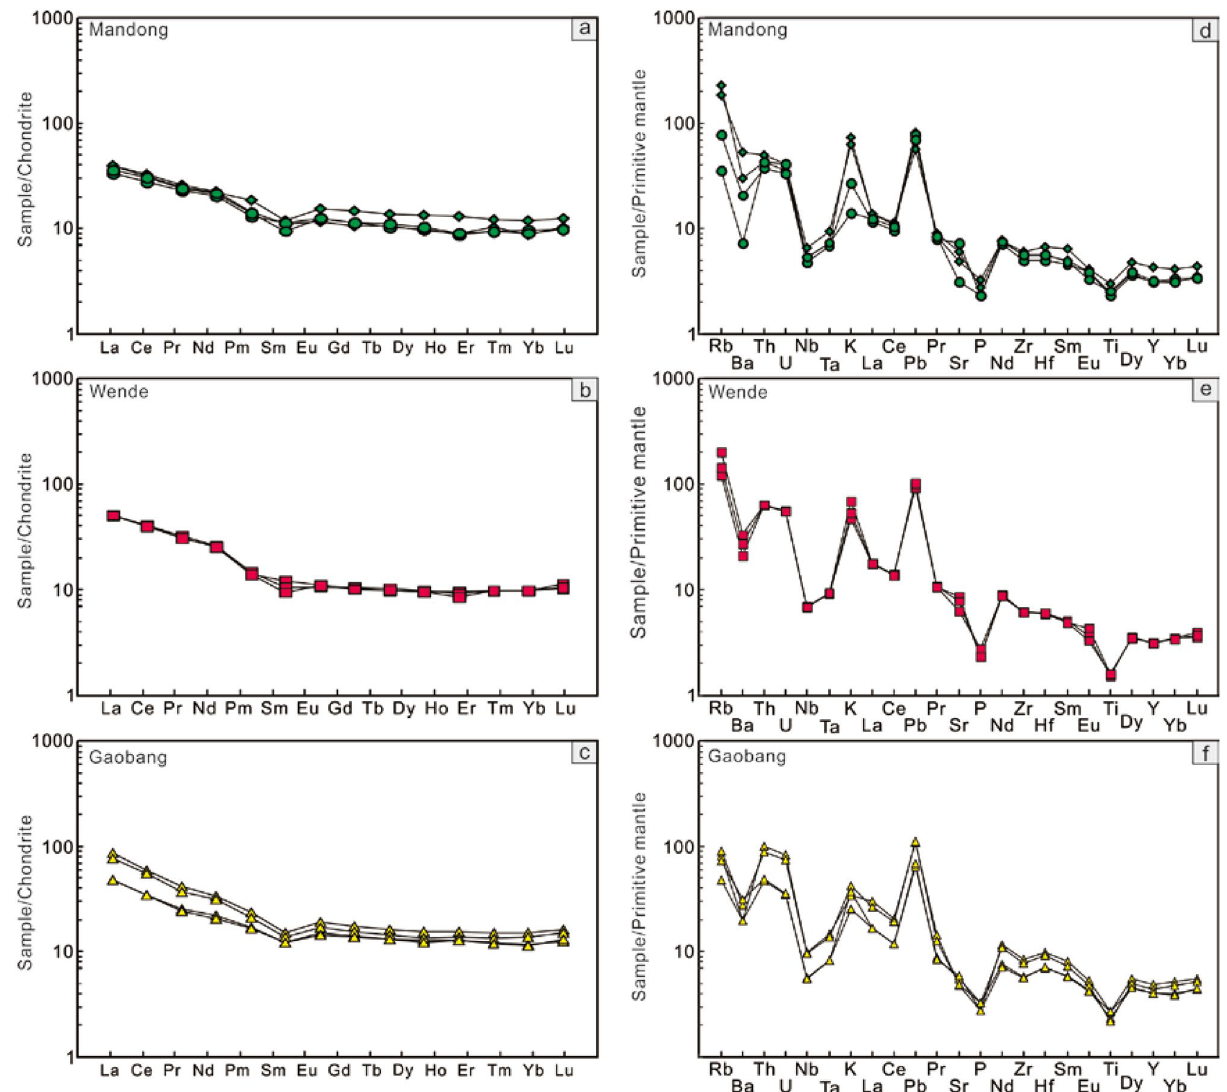
Figure 4. Chondrite-normalized REE patterns ( a – c ) and primitive mantle normalized multi-element variation diagrams ( d – f ) of the studied mafic